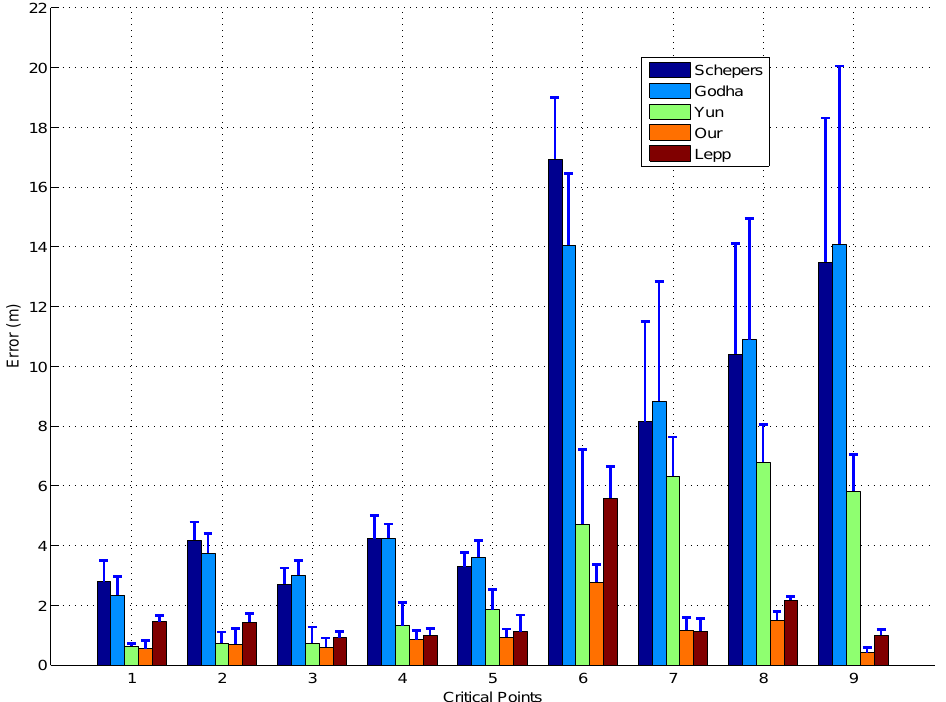
Figure 5. Indoor walking: the average and standard deviation of distance errors between the estimated positions and actual positions of the 9 critical points over 5 trials. For the traditional methods without map information, the distance errors had significant increment as the walking distance increased due to acceleration integration